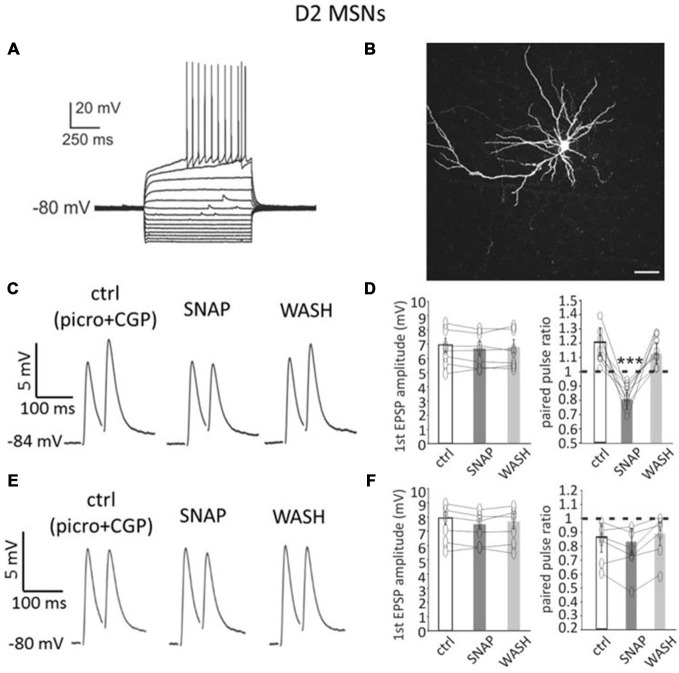
SNAP converted paired-pulse facilitation into paired-pulse depression in D2-MSNs. (A) Responses of a D2-MSN to current injections (20 pA increments). Rheobase current was 80 pA. (B) Neurobiotin staining of the neuron in A revealed its dendritic arborization and spines. Scale bar = 50 μm. (C) In a D2-MSNs paired-pulse facilitation was present in control solution (which contained GABAA and GABAB receptor antagonists), but was reversibly converted into paired-pulse depression by SNAP, that reduced the amplitude of the second evoked EPSP. Each trace in this and other figures showing paired pulse responses is the average of 50 consecutive responses. (D) Effects of SNAP on the first evoked response and the paired-pulse ratio of D2-MSNs that displayed paired-pulse facilitation in control solution. (E) In another D2-MSN, paired-pulse depression of corticostriatal responses was present in control solution. In this case, application of SNAP failed to significantly affect these responses. (F) Effects of SNAP on the first evoked response and on paired-pulse ratio of D2-MSNs that displayed paired-pulse depression in control solution.